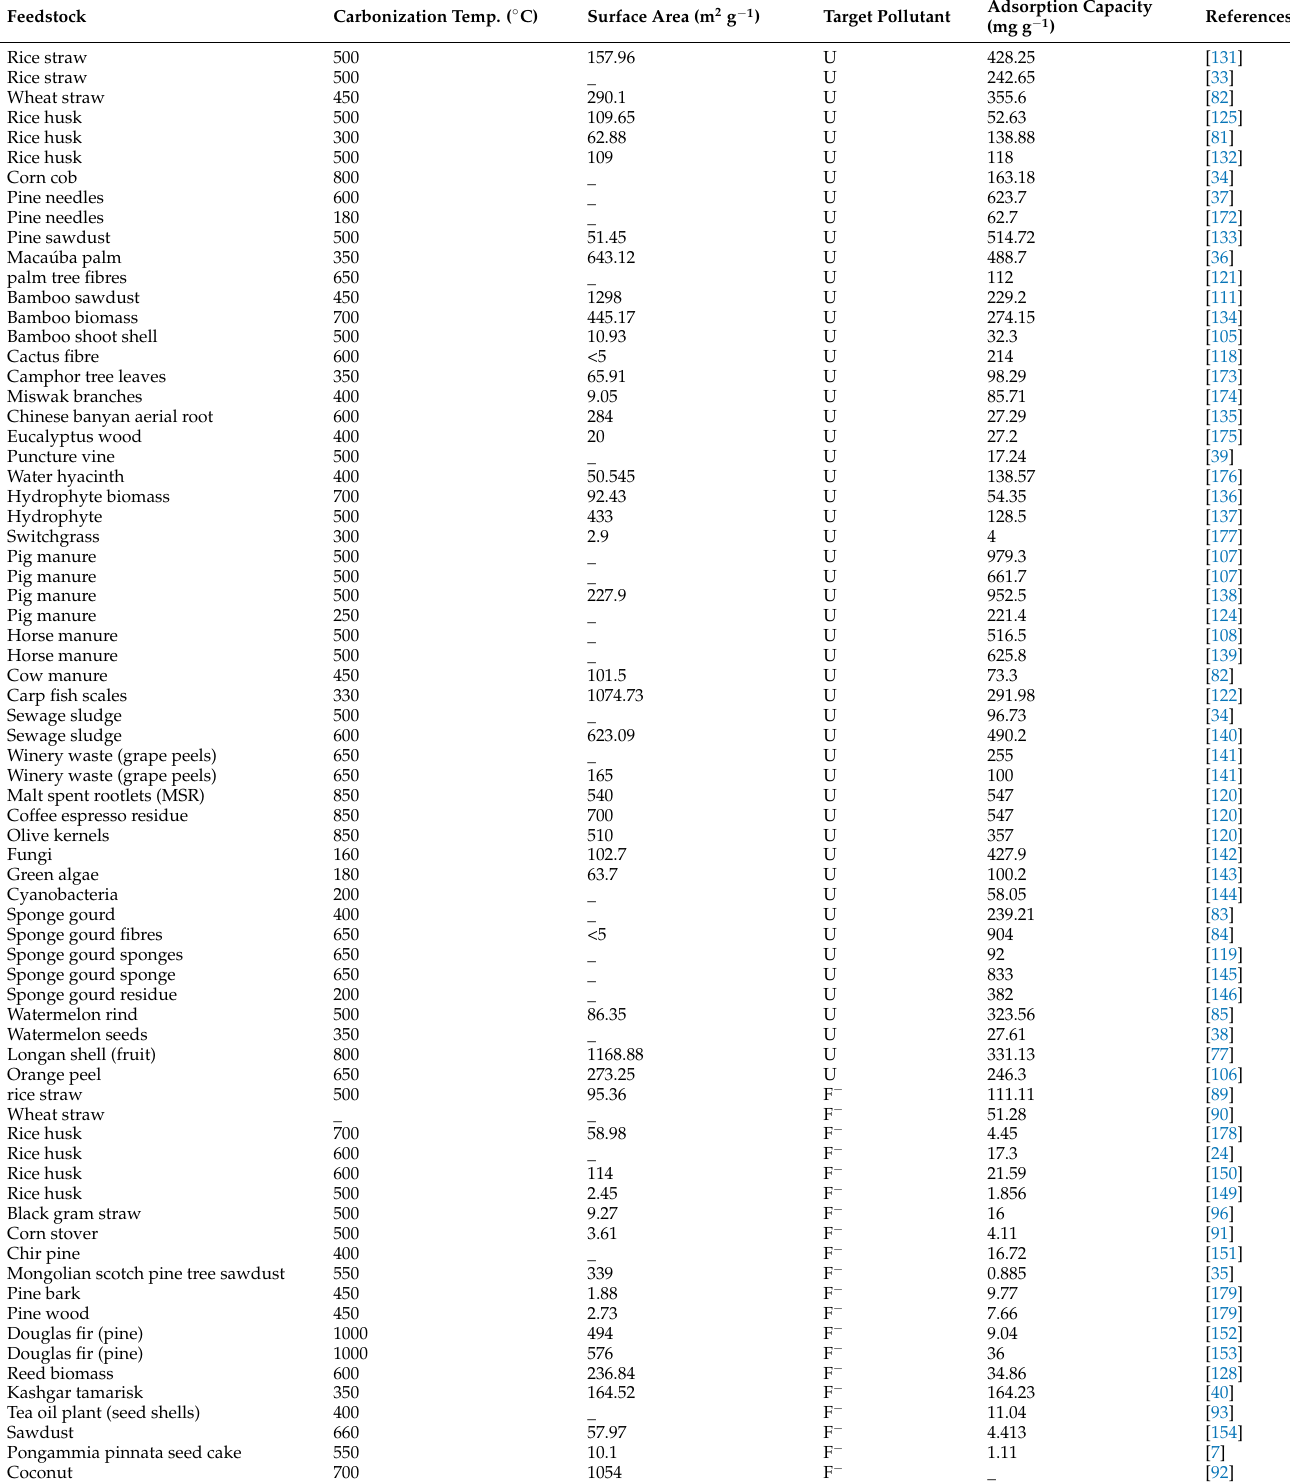
Table 6. Effect of carbonization temperature on U and F −